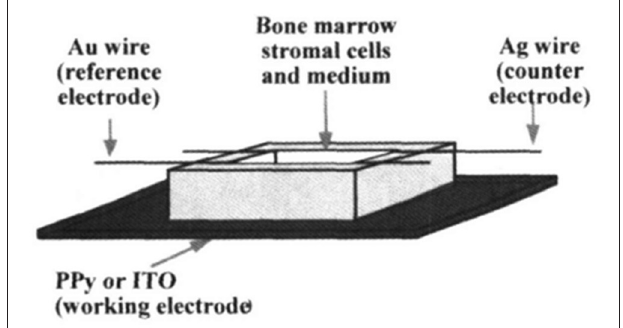
FIGURE 1 | Scheme for Electrical stimulation (ES) of BMSC on polypyrrole (PPy) thin films. Reproduced from (64) with the permission of the Materials Research